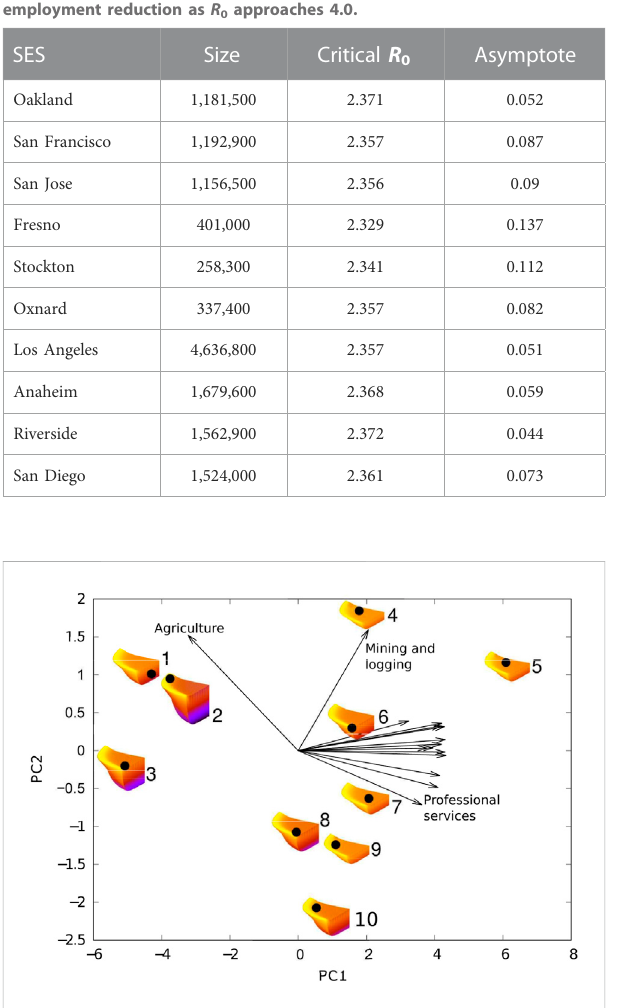
with initial employment and location (Figure 4B), with larger, coastal systems experiencing relatively fewer job losses (Pearson ’ s correlation, E * and log-transformed E (0), r 2 = − 0.712, p = 0.014, α = 0.05) and slower rates of increasing E * with increasing R 0 (Pearson ’ s correlation, r 2 = − 0.736, p = 0.01). Neither logistic coef fi cient, growth rate, or asymptotic value was signi fi cantly correlated with SES age structure. The mid-point of the logistic relationship between E * and R 0 (Figure 4A) is the point at which an incremental change of R 0